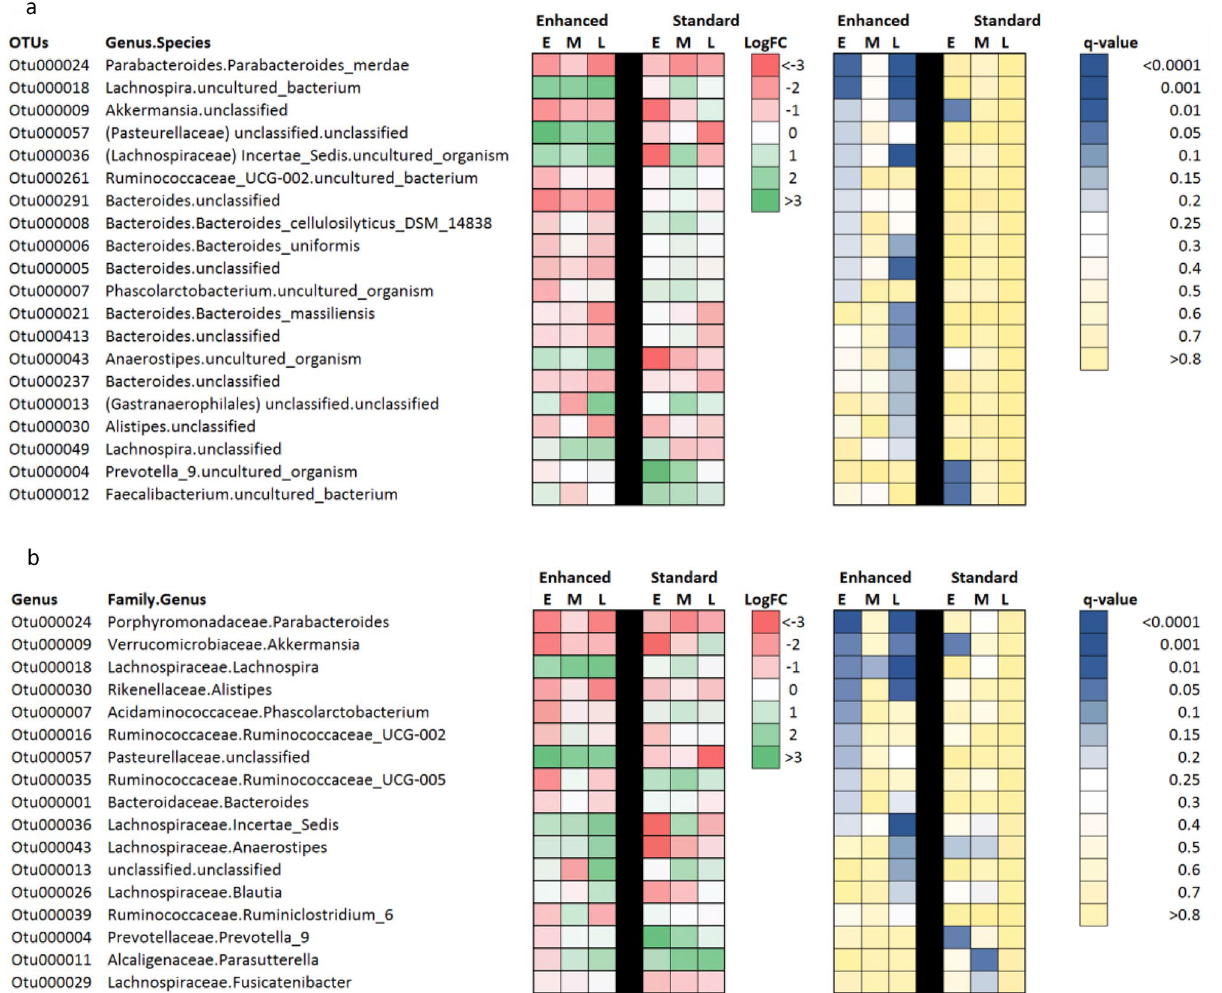
Figure 7. Associations between diet and OTUs. Differences were identified in 20 OTUS at the species level ( a ) and 17 at the Genus level ( b ). Both pre-mission timepoints were used as a baseline, FDR < 0.25. E = early, M = mid, and L = late time in mission. Changes in the abundance of taxonomic groups were estimated with the R package DESeq2 (v 1.28.1, https:// bioco nduct or. org/ packa ges/ relea se/ bioc/ html/ DESeq2. html) [PMID: 25516281] and heatmaps representing their associated Log2(Fold Change) and FDR (q-values) were generated in Microsoft Excel (v 16.63.1).